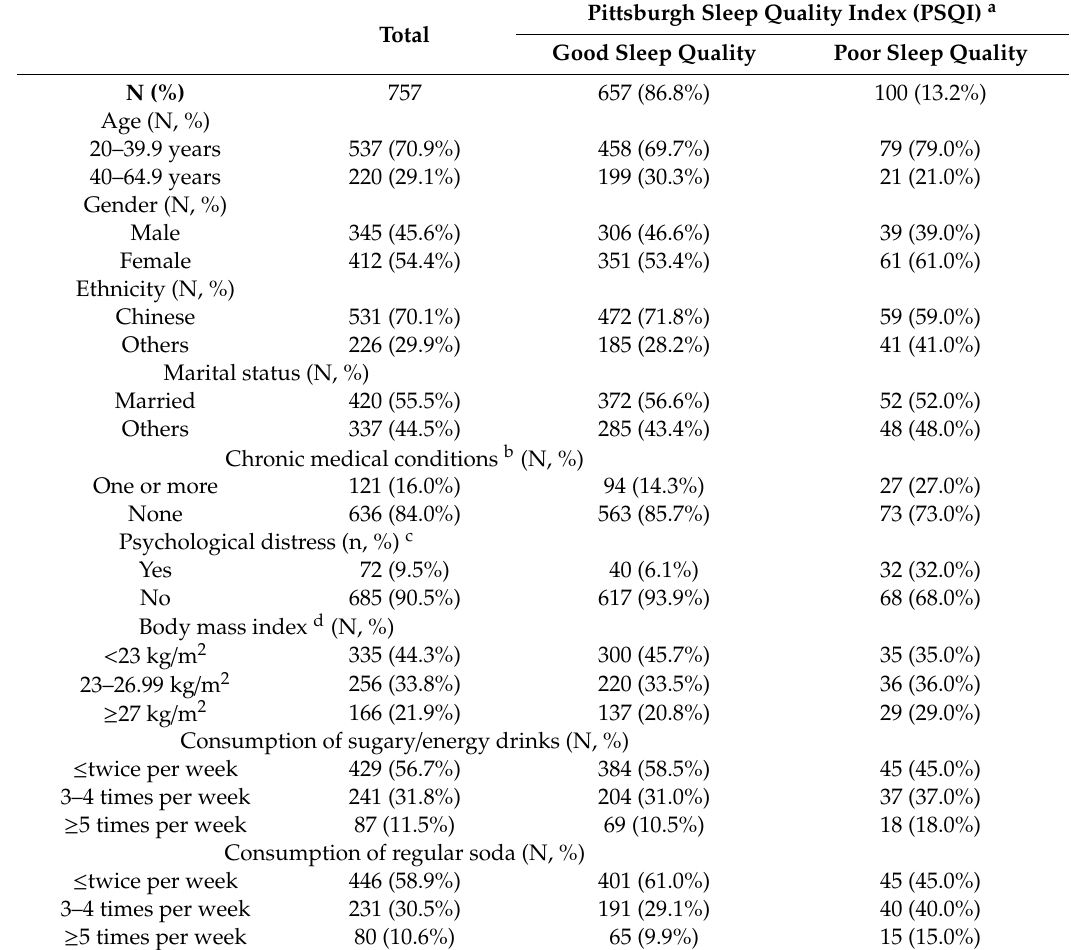
Table 1. Demographic Characteristics of the